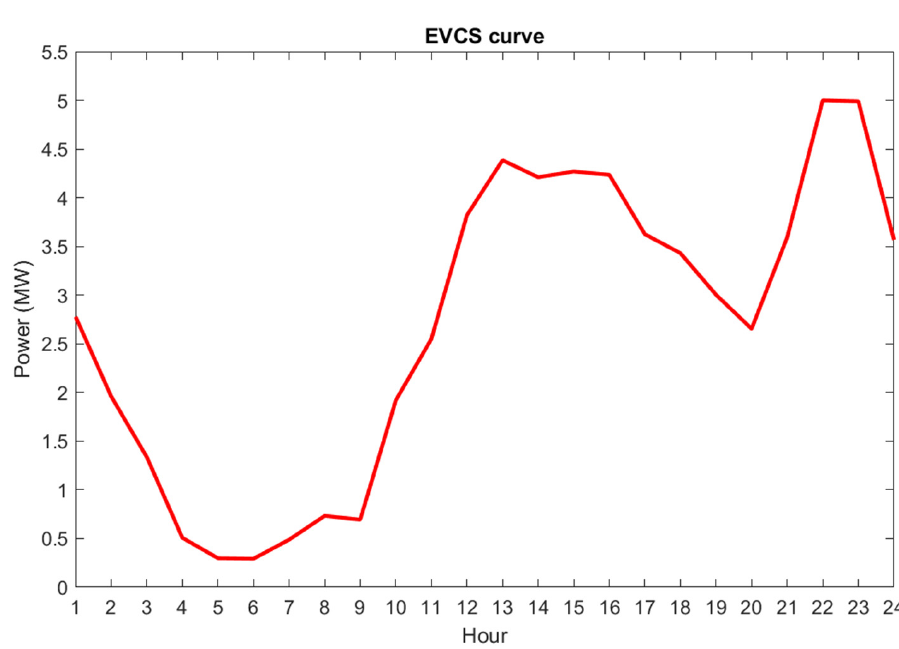
Figure 5. The typical curve of the EVCS charging profile for a day.